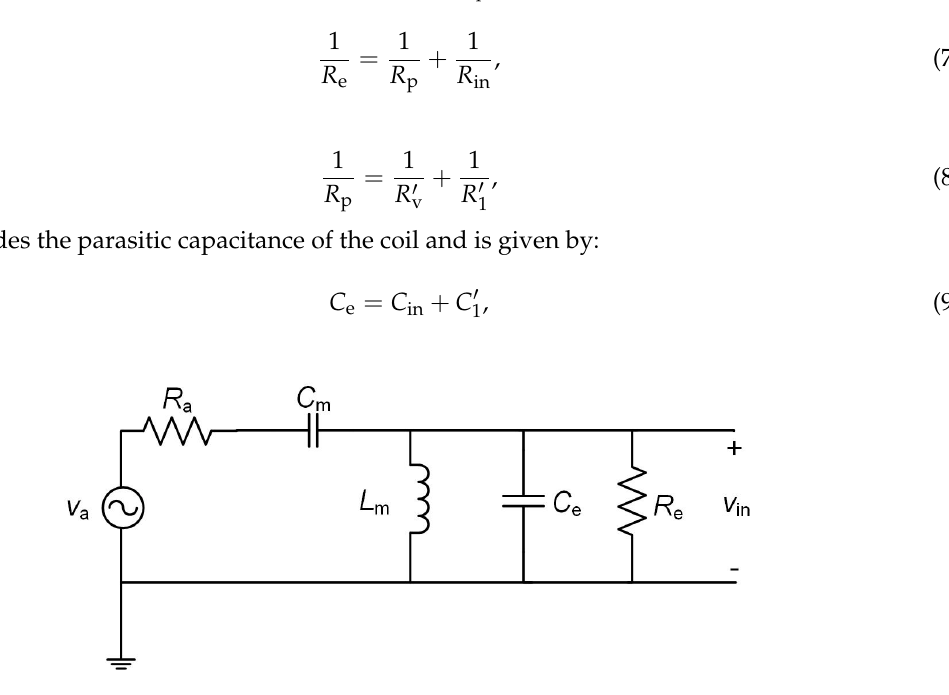
Figure 4. Equivalent circuit of the rectenna taking into account the inductor model of Figure A4 with R 2 neglected.